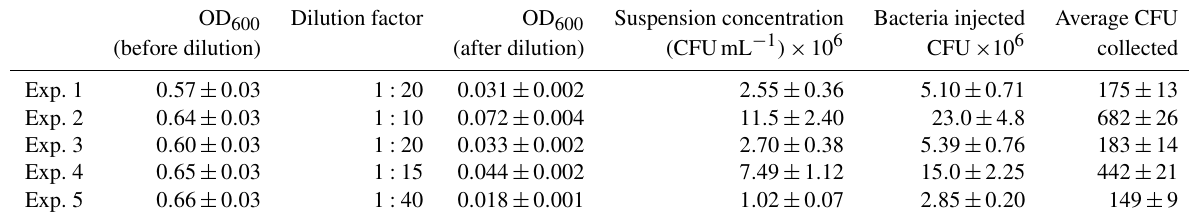
Table 4. Bacteria concentration ( E. coli ) in the aerosolized solution and average number of colonies counted on one Petri dish. OD 600 Dilution factor OD 600 Suspension concentration Bacteria injected Average CFU (after dilution) (CFUmL − 1 ) × 10 6 CFU × 10 6